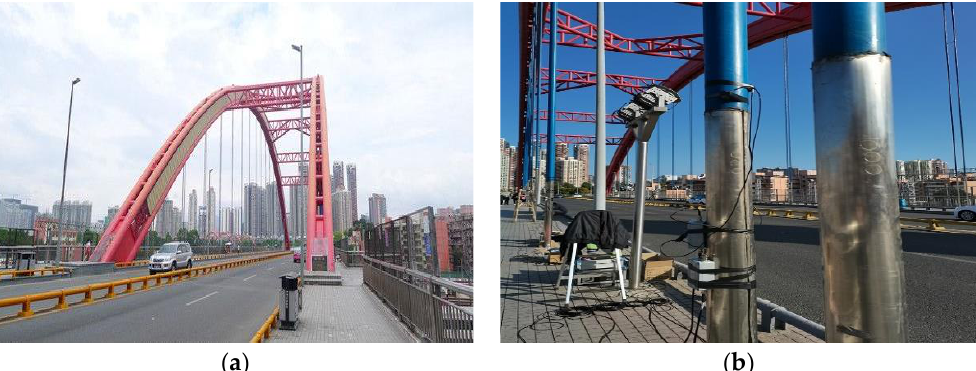
Figure 5. Experiment site: ( a ) panoramic view of Shen Zhen Caihong Bridge; ( b ) device connection.